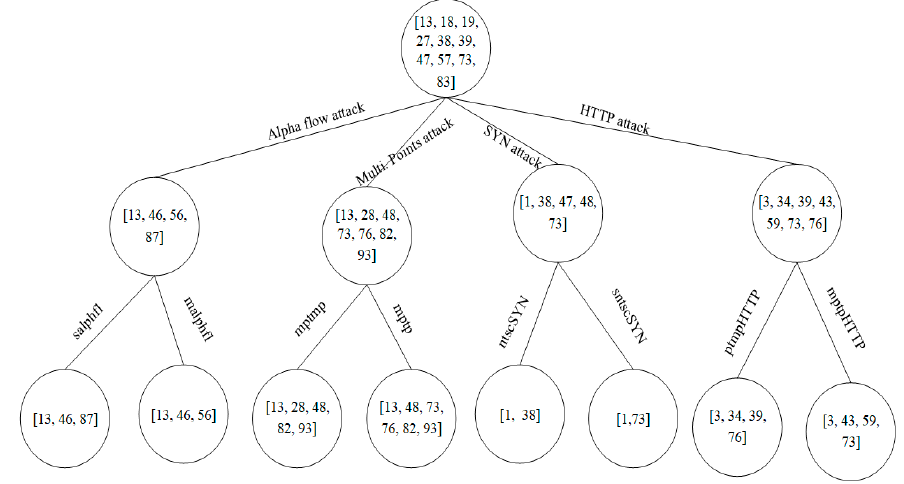
Figure 14. Attack vector feature tree. Table 8. Performance comparison of three models of 100 k WIDE TCP flow datasets.